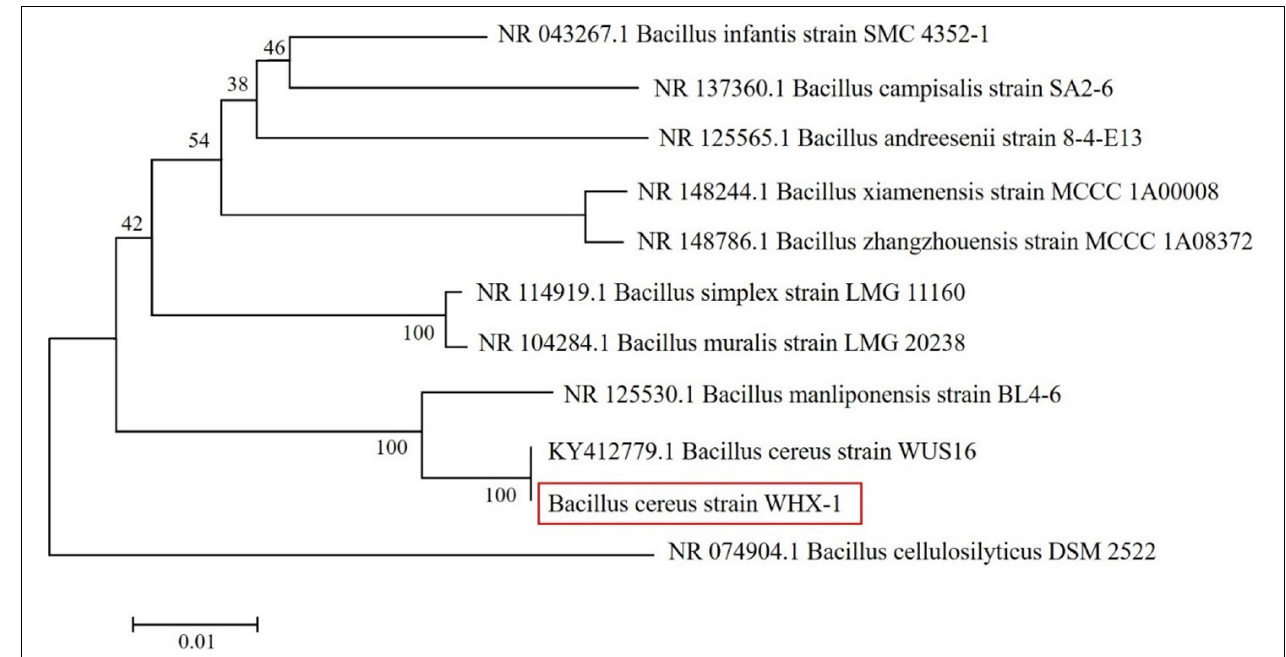
FIGURE 1 | Phylogenetic tree of the strain screened from Cr-contaminated